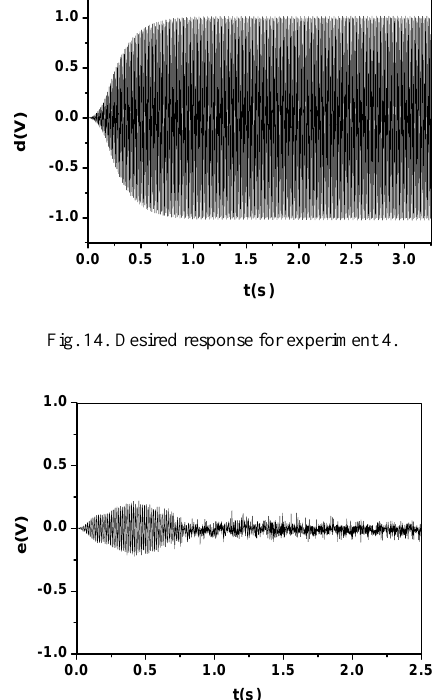
Fig. 15. Error function based on the LMS algorithm for the case C 4 .